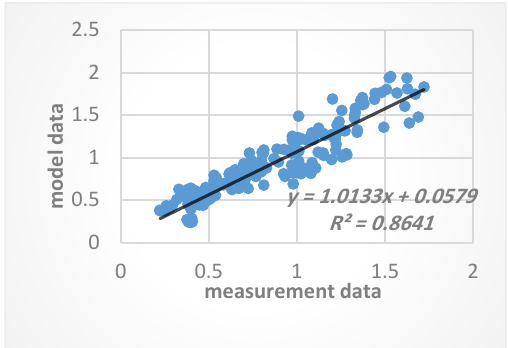
Figure 5. The regression line for Amirabad Port.